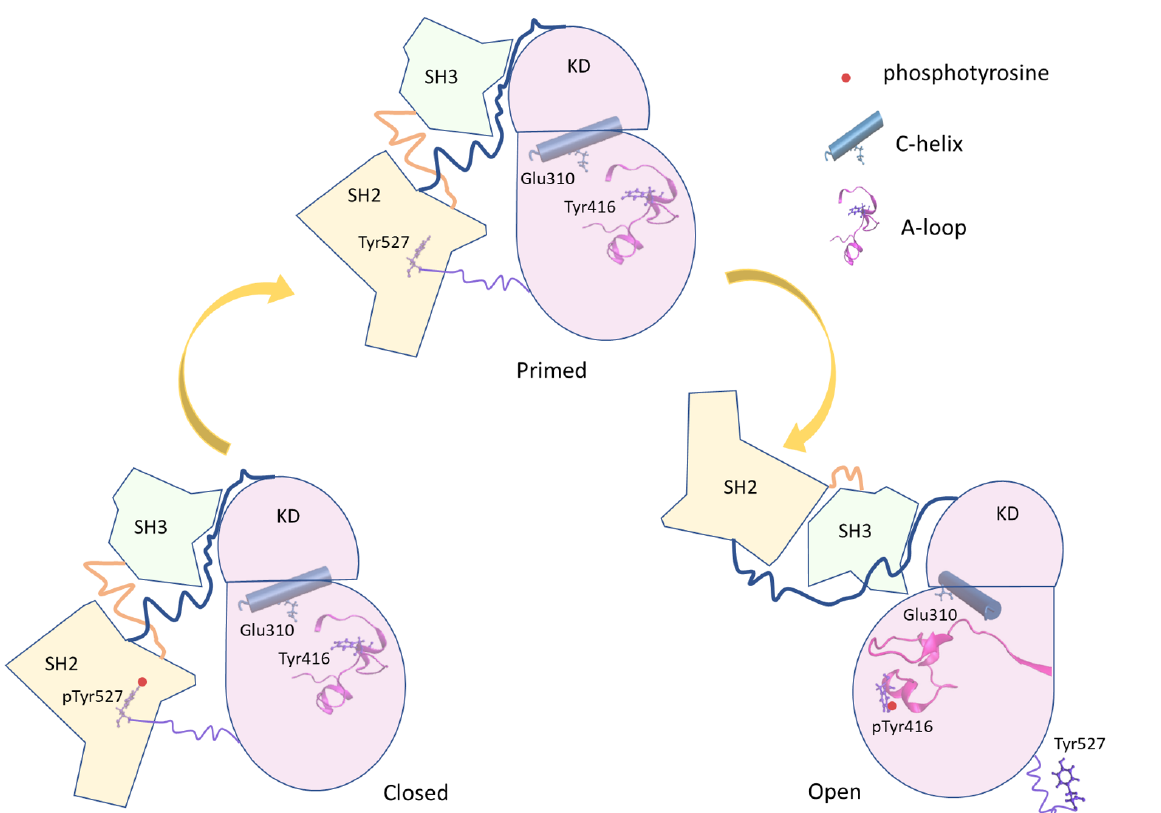
Figure 1. Scheme of the principal conformational states of the full-length Src. The three Src domains are represented in different colors (SH2 in yellow, SH3 in light green, and Kinase Domain (KD) in pink). The linker regions are represented by lines. Important protein elements (phosphotyrosine, C-helix, and A-loop) are added to the